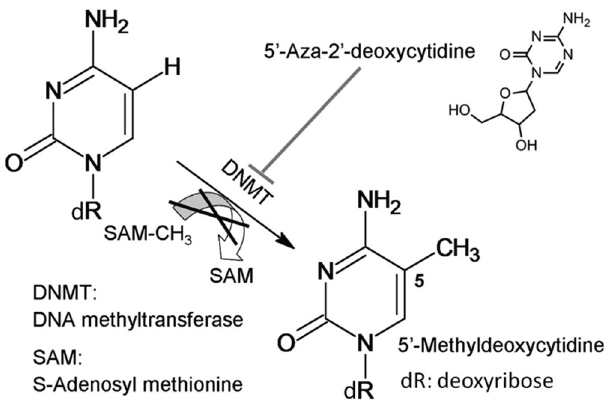
Figure 1. Reaction scheme of DNA